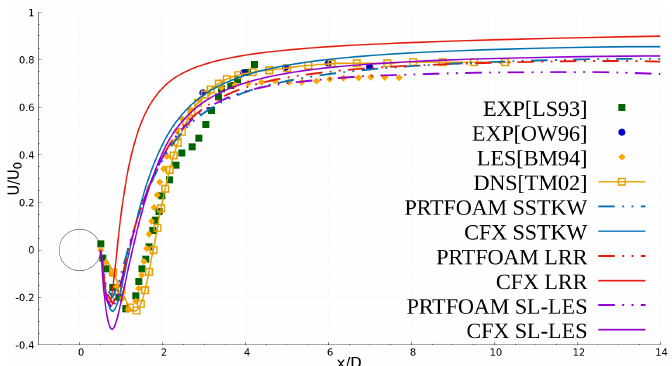
Figure 9. Comparison of mean stream-wise velocity components at centerline behind the cylinder including our numerical simulation data, the direct numerical simulations (DNS) [34], and experimental data [35–37]. In a distance behind the cylinder, the velocity shows a negative value, which means that in this distance the velocity and the incoming flow are in the opposite direction, thus forming a back flow.